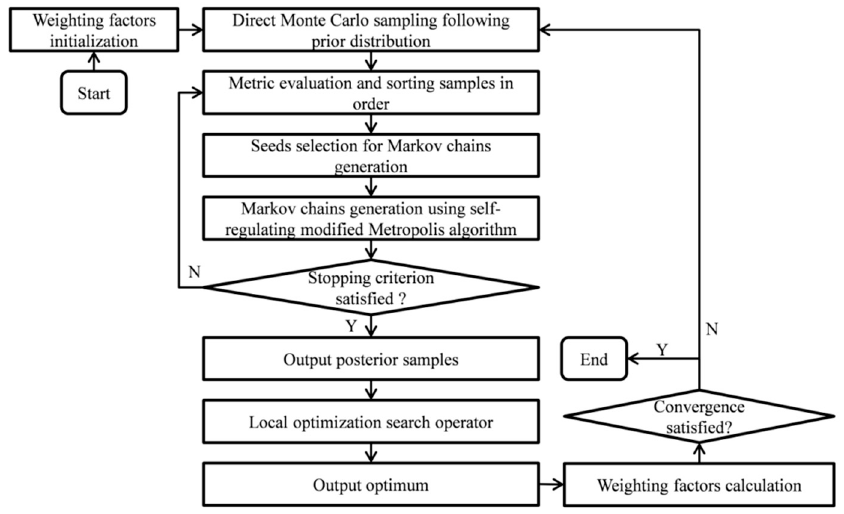
Figure 2. The flowchart of the proposed algorithm.